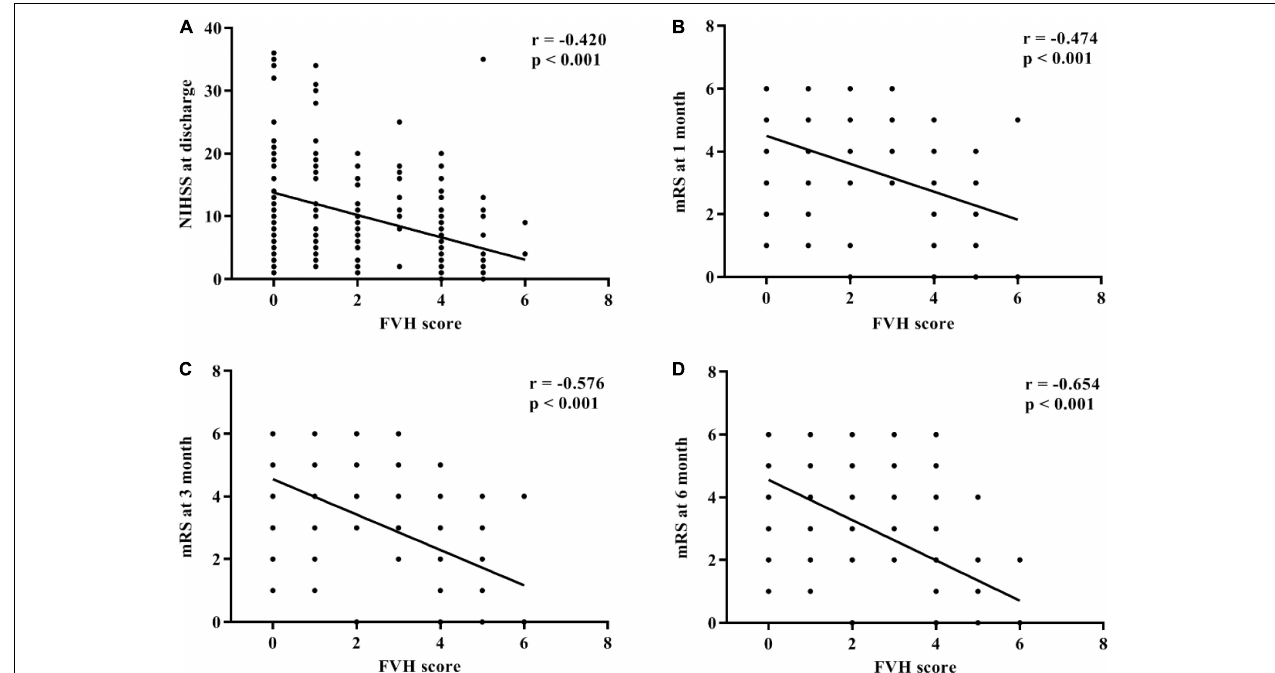
analyzed the clinical data of AS patients with LVO. Hence, the present findings are based on solid evidence and have important clinical value to guide the treatment of AS stroke.